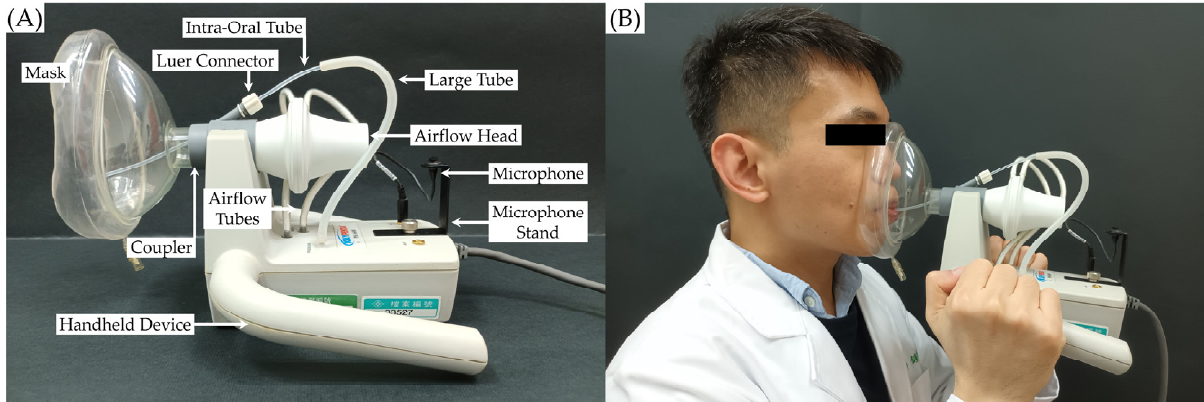
Figure 3. The Phonatory Aerodynamic System external module. ( A ) The coupler is attached to the airflow head (pneumotach) and the intra-oral pressure kit is attached to the handheld device; the glottal airflow rate is estimated from the oral airflow rate during vowel production and the subglottal air pressure is estimated from the intraoral air pressure produced during stop consonant production. The microphone is placed in its stand; the acoustic signal is picked up by a microphone and the estimate of sound-pressure level (SPL) is taken from the acoustic signal at the same time points in each vowel so that airflow measurements are obtained to facilitate the interpretation of airflow and air pressure measures. ( B ) The correct way to hold the Phonatory Aerodynamic System external module during data capture and the signals from airflow, air pressure, and microphone systems are acquired simultaneously during phonatory tasks.